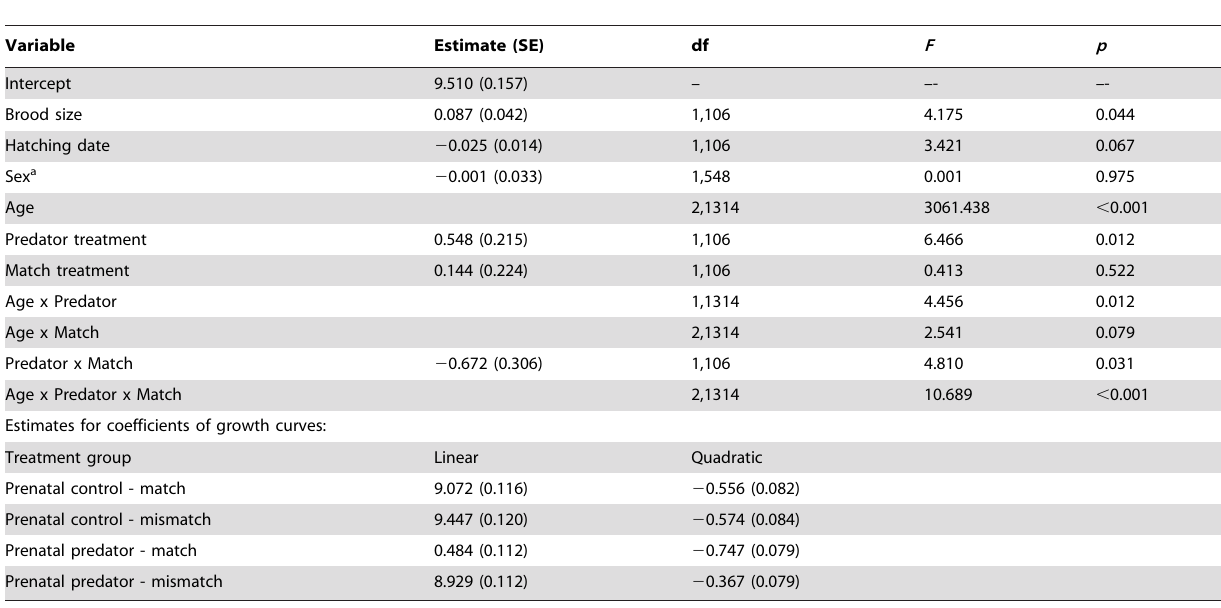
Table 3. ANOVA table and estimated coefficients – linear mixed model for nestling mass.